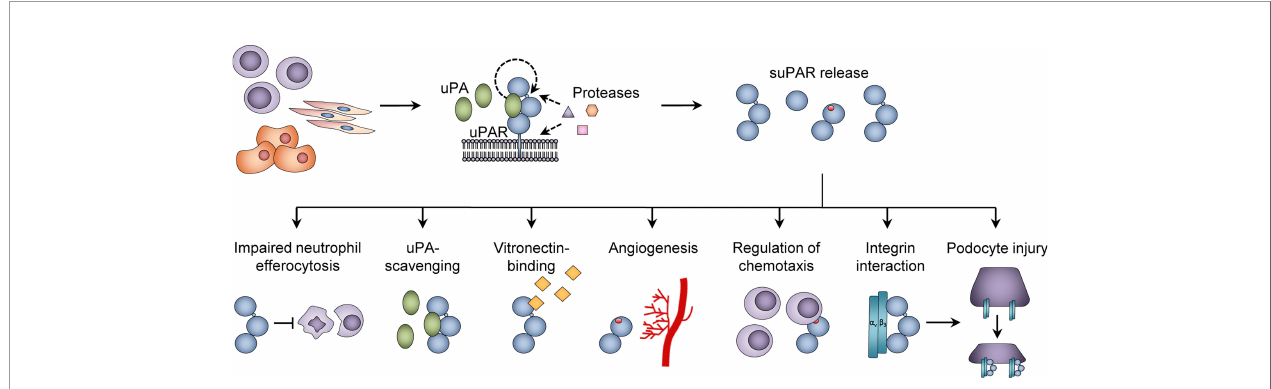
FIGURE 3 | Functions of suPAR. The urokinase plasminogen activator receptor (uPAR) is expressed on the surface of immune cells, endothelial cells, and vascular smooth muscle cells, and proteolytic cleavage in the linker region or glycosyl phosphatidylinositol (GPI) anchor of uPAR generates soluble uPAR (suPAR). Various functions of suPAR have been proposed, including inhibition of neutrophil efferocytosis; binding of urokinase plasminogen activator (uPA) and vitronectin; stimulation of angiogenesis via endothelial sprouting and tube formation; promoting chemotaxis; and interactions with b 3 integrin, which is suggested to cause podocyte injury in the glomeruli. Adapted from Rasmussen, LJH (2018) (19) with